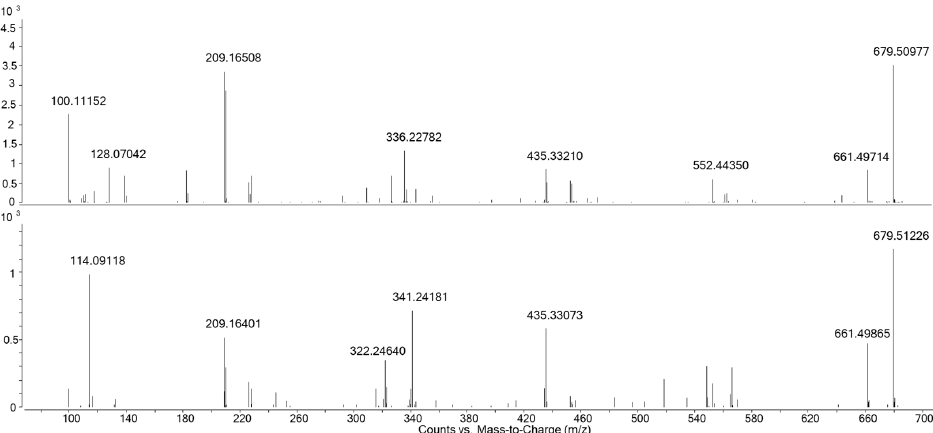
Figure 3. MS/MS data of the cyclic hexamer of PA 6.6 ( top ) and PA 6 ( bottom ), recorded with a collision energy of 40 V.